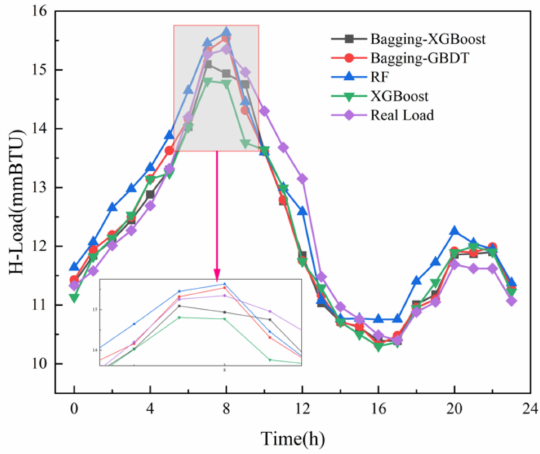
Figure 16. Heat load forecast